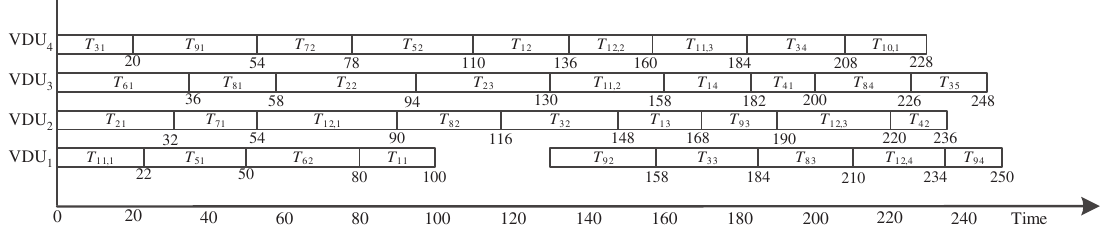
Figure 7: Gantt Chart of CR.